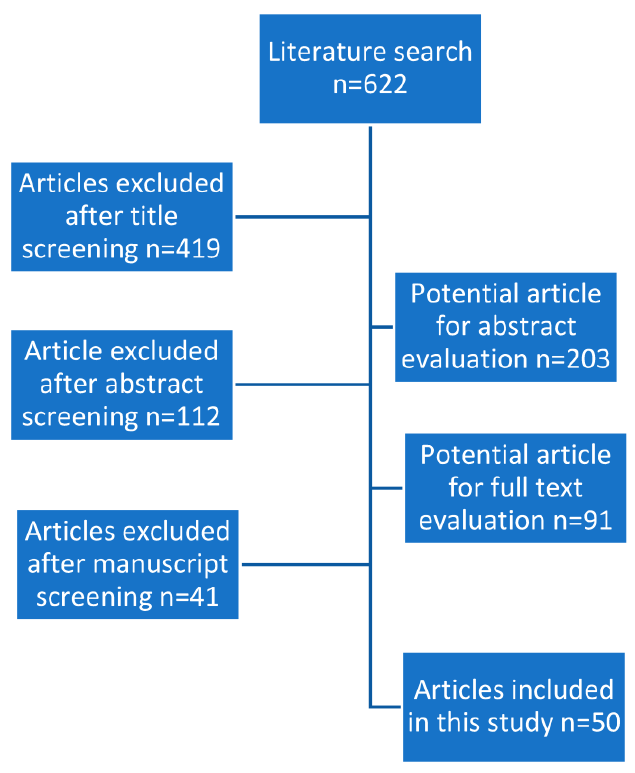
Figure 1. PRISMA flowchart of study selection.